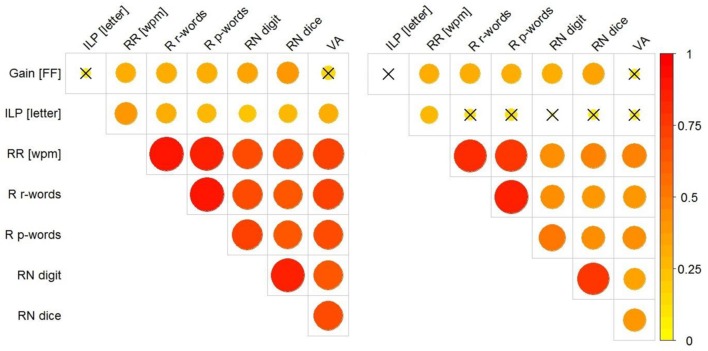
Correlations (Pearson’s r) between the proportional reduction of first fixation duration in relation to the salience of the parafoveal preview (Gain [FF]), the ILP on the target words (ILP), the word-per-minute (wpm) rate of reading aloud sentences (RR; obtained from the eye tracking task), the wpm-rate of reading aloud lists of words (R r-words) and pseudowords (R p-words), the items-per-minute measure of the two versions of the rapid naming task (i.e., RN digits and dice faces) and the performance in the visual attention task (VA). The (Left) panel presents the correlations irrespective of the Grade-level of the children; the (Right) panel shows the correlations after partialling-out Grade. The size of the correlations is represented by the size (and the color) of the circles; correlations of r > 0.23 were significant (p < 0.05); insignificant correlations are marked with an X. For creating this Figure, we used the corrplot-package (Wei, 2013).